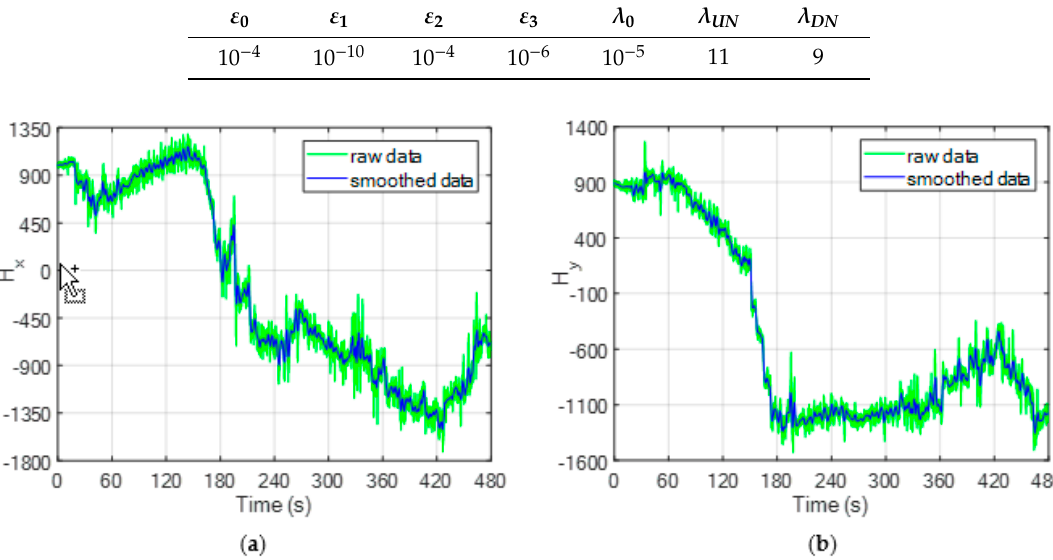
Table 1. Dimensionless parameters characterizing the LM-based magnetic calibration algorithm.